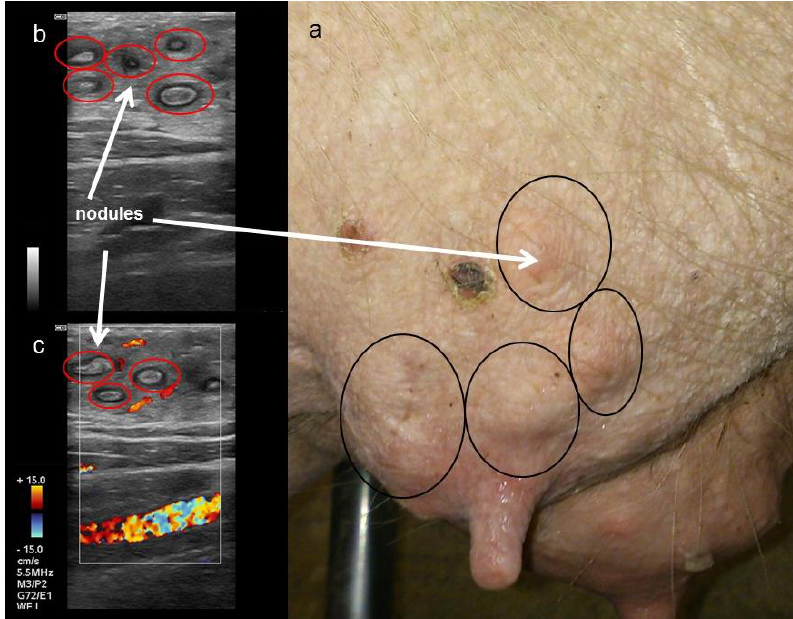
Figure 7. Picture ( a ) and sonographic images ( b , c ) of a sow´s mammary gland at weaning. ( b : B-mode, c : Doppler-mode). Red circles mark chronic nodular alterations characterised by ( b ) hyperechogenic centres with small anechoic margins and ( c ) without a Doppler signal. Nodular alterations are circled in black on the right picture ( a ).